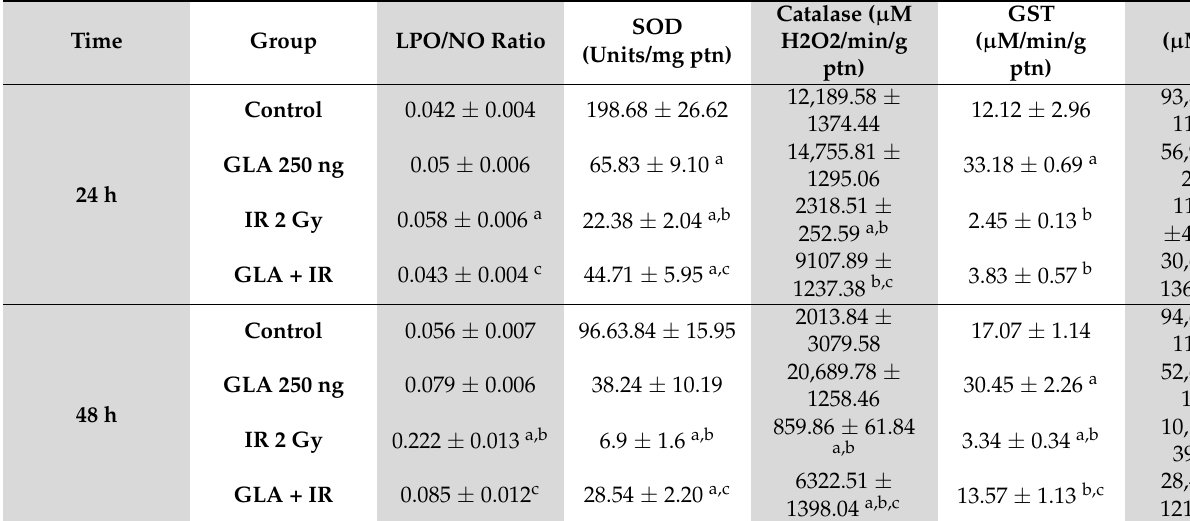
Table 2. Estimation of antioxidant status in RAW 264.7 cells. RAW 264.7 cells were pre-treated with 250 ng/mL GLA 24 h prior to irradiation at 2 Gy (at 1 Gy/min). Supernatant and cell lysate were obtained at 24 and 48 h post-radiation, and were used for the estimation of various antioxidants. Values (n = 6) expressed as mean ± SE. Statistical significance was determined by t -test ( p < 0.001). Significance expressed as a , b , and c significance with control, GLA, and IR of same time point, respectively. C, control; GLA, gamma-linolenic acid; IR, irradiation (2